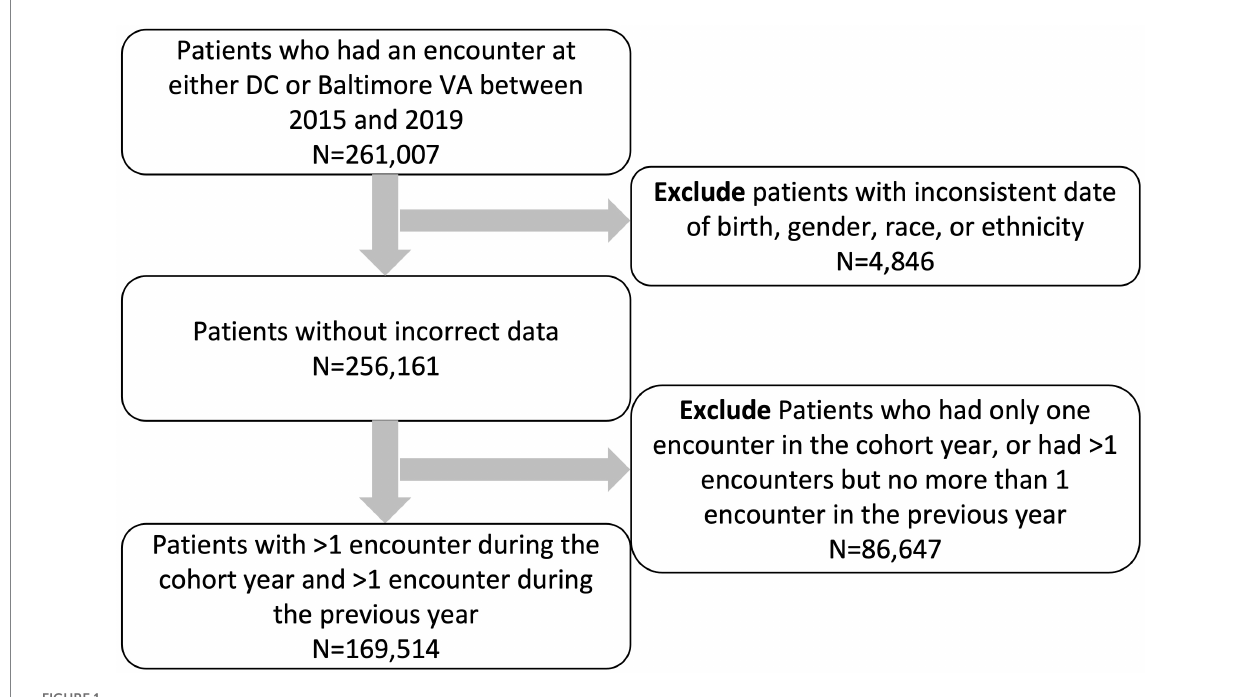
FIGURE 1 Cohort selection flow